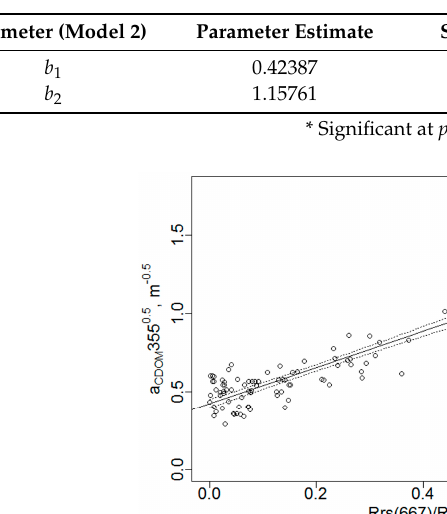
Figure 7. Plot of the in situ a CDOM 355 0.5 values versus the in situ band ratio R rs (667)/ R rs (488) of the test data set. The solid and dashed lines are the OLS fitted Model 2 and the 95% confidence interval, respectively.